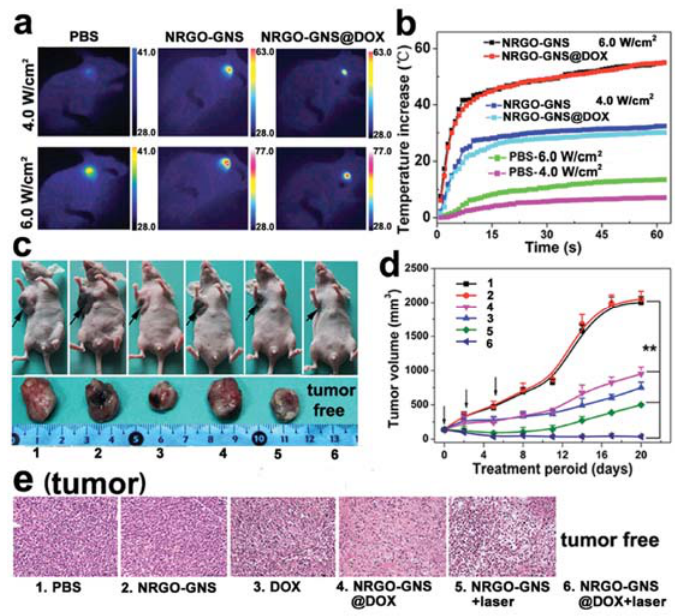
Figure 8. ( a ) IR thermal images of PBS-, NRGO-GNS-, or NRGO-GNS@DOX-injected 4T1 tumors after laser illumination; ( b ) Photothermal effect of PBS, NRGO-GNS, or NRGO-GNS@DOX in orthotopic 4T1 tumor-bearing mice in vivo; ( c ) Representative photographs of the tumor-bearing mice (top panel) and the tumor tissue (bottom panel) taken at the 20th day post the first treatment (the black arrows indicated the position of the primary tumors); ( d ) Tumor volume change examined during the therapeutic period ( n = 6, ** p < 0.01, compared to PBS injected mouse controls); ( e ) H&E staining of the tumor sections at the end of antitumor study (200 × ). NRGO = nanosized reduced graphene oxide. GNS = gold nanostar. Reproduced with permission from [66]. Wiley,